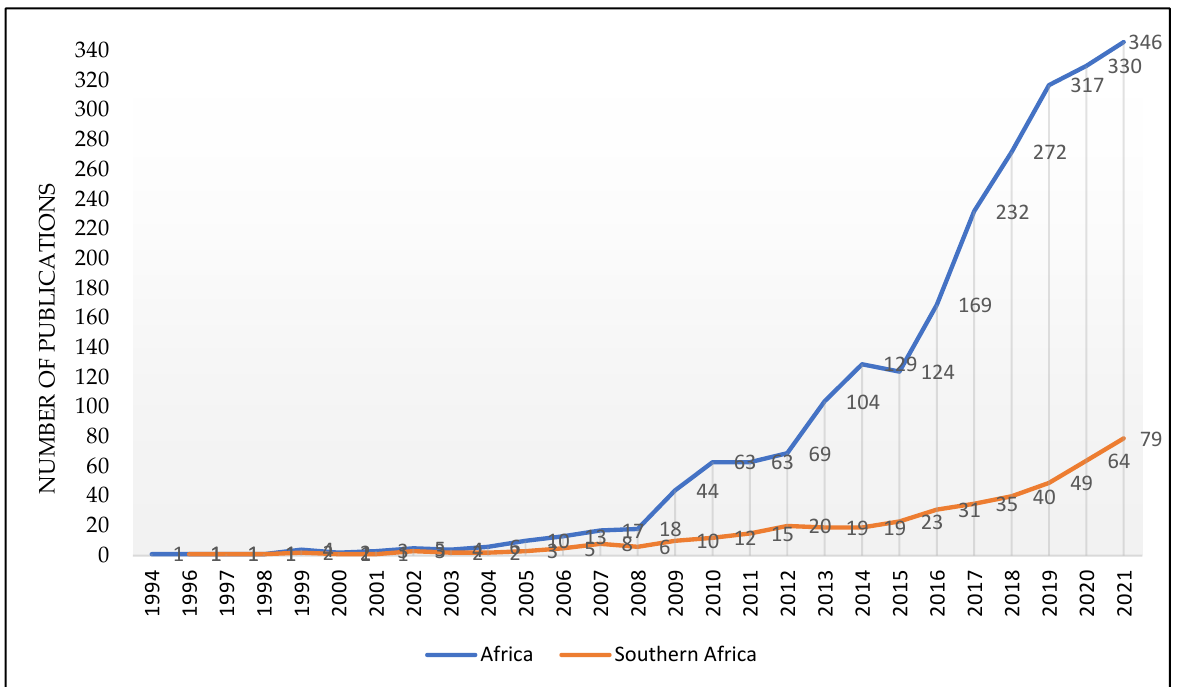
Figure 2. Annual number of ESs publications in Africa and southern Africa from 1994 to 2021.